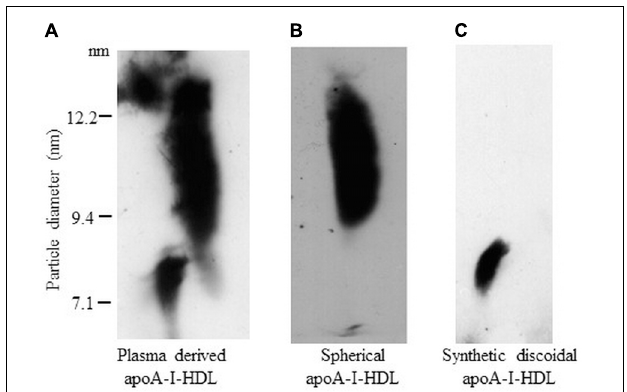
FIGURE 1 | Characterization of HDL by 2D-GGE. Total HDL, purified from human plasma, were separated by two-dimensional electrophoresis and transferred onto a nitrocellulose membrane, on which different HDL subclasses were detected by immunoblotting using anti-human apoA-I antibody. (A) Plasma derived apoA-I-HDL (total plasma HDL). (B) Spherical apoA-I-HDL, derived from plasma HDL preparation after incubation for 2 h at 37 ◦ C with chymase-containing granule remnants, which degrades small discoidal HDL particles. (C) Synthetic discoidal apoA-I-HDL, prepared by the cholate dialysis method.